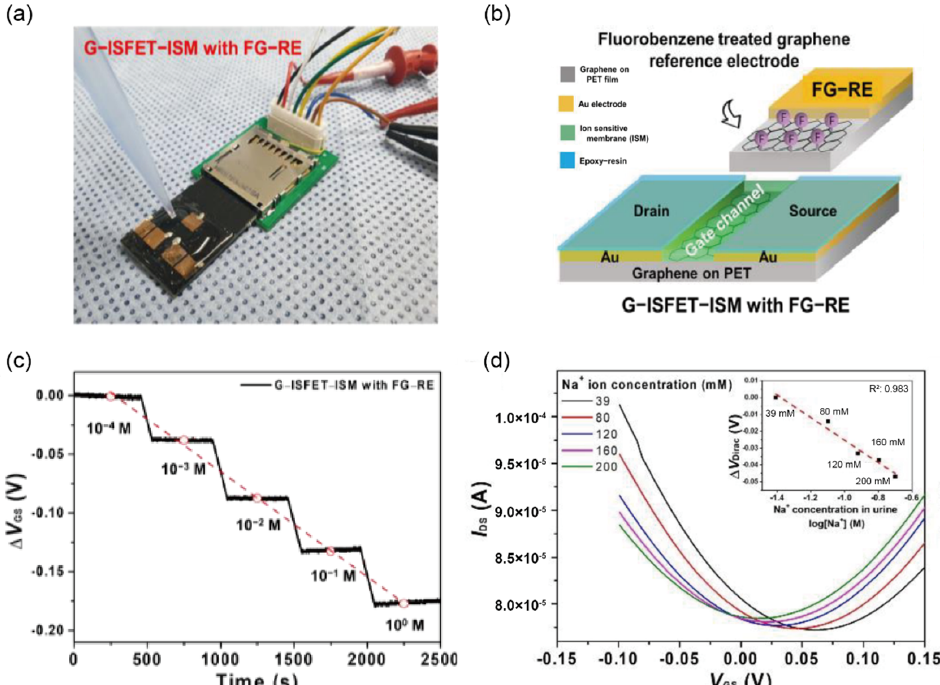
Figure 12. Selective detection of sodium ions in clinical samples ( a ) Schematic diagram of the experimental setup and ( b ) biosensor components of a two-dimensional structure composed of G-ISFET-ISM and FG-RE for detecting sodium ions on the PCB designed as an SD card. ( c ) Real-time response of G-ISFET with FG-RE toward different concentrations of sodium ions from 0.1 mM to 1 M. The gate voltage (V GS ) was measured at V DS = 0.05 V and I DS = 180 µ A. ( d ) Corresponding transfer characteristics are dependent on the concentration of sodium ions in real human patient samples. The top-right corner inset shows the linear relation between the shift at the Dirac point (V Dirac ) and the concentration of sodium ions with a sensitivity of − 0.29 mV/mM. (Reprinted with permission from Ref. [51]; copyright 2021, MDPI.)